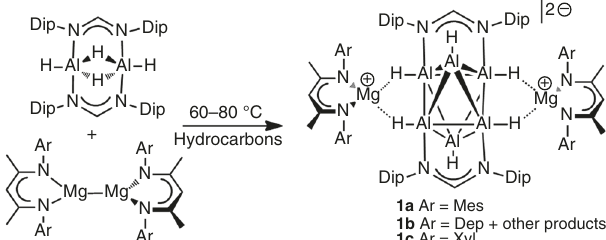
Fig. 1 Formation of compounds 1 (Mes = C 6 H 2 Me 3 -2,4,6; Dep = C 6 H 3 Et 2 - 2,6; Xyl = C 6 H 3 Me 2 -2,6). The compounds 1 are prepared by reduction